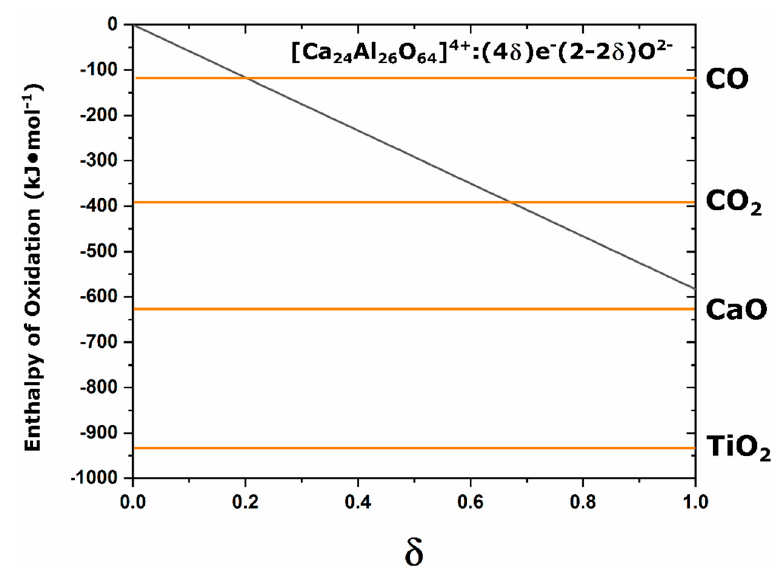
Figure 13. Enthalpy of oxidation of C12A7 as a function of electron conversion ( δ ) compared to the enthalpies of oxidation of C, Ca, and Ti [16,41–43].